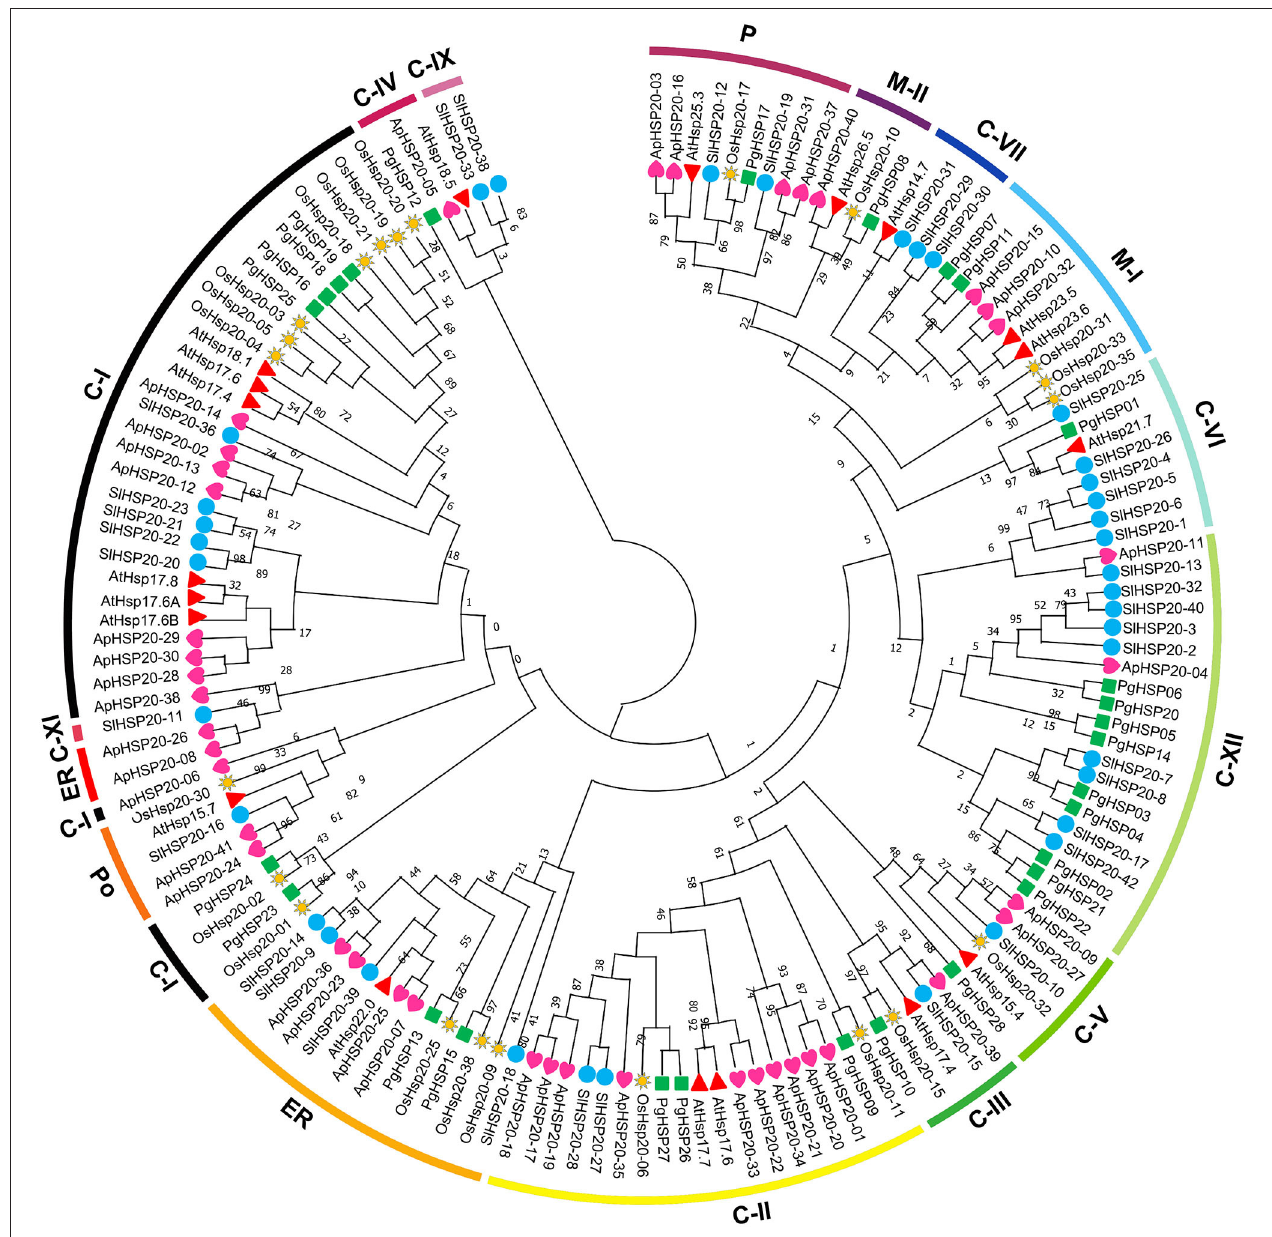
FIGURE 8 | Phylogenetic analysis of representative HSP20 proteins from Arabidopsis , rice, tomato, and apple along with the 28 predicted HSP20 genes from the pearl millet genome. The phylogenies were constructed by using MEGA.X by the maximum likelihood (MLE) method with a 1,000-bootstrap replication. The 16 subfamilies were distinguished with different colored arcs (https://figshare.com/s/17c47e8fe8fa000e992f).